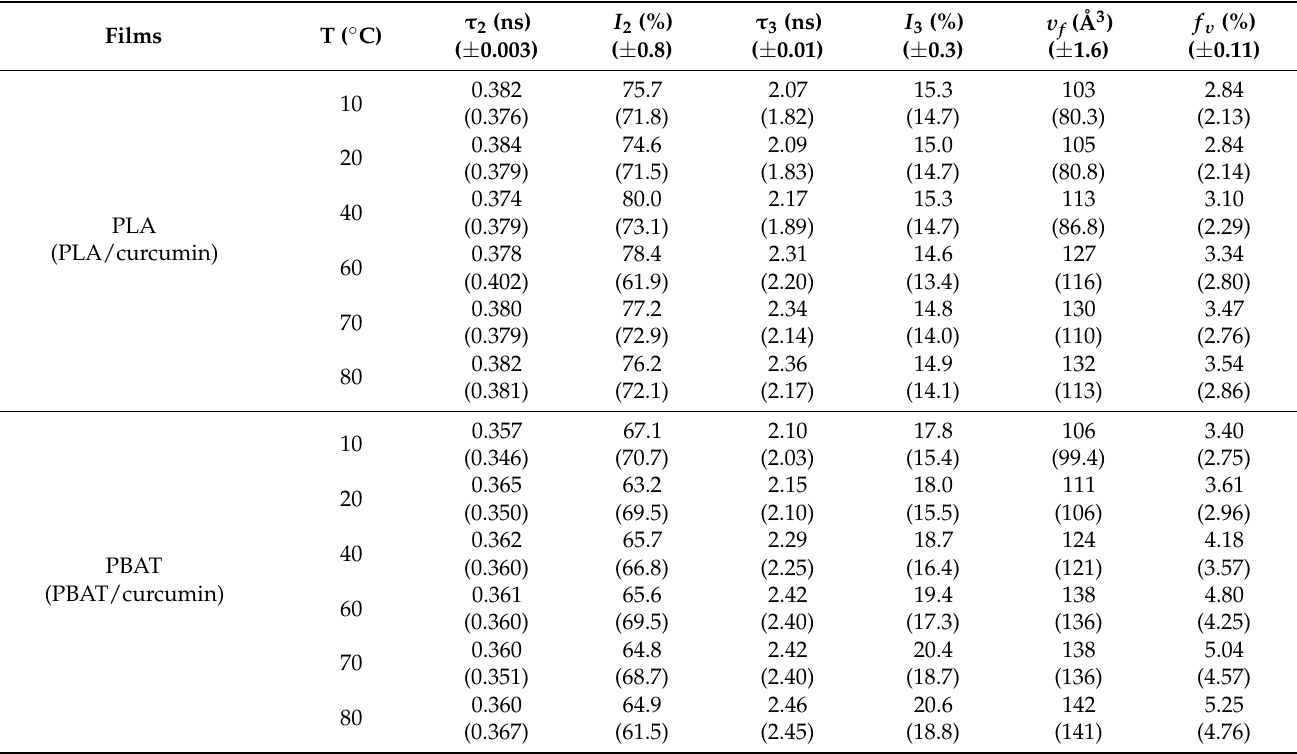
Table 2. PALS parameters as lifetimes ( τ 2 and τ 3 ) and intensities ( I 2 and I 3 ) with free volume hole size ( υ f ) and free volume fraction ( f υ ) in terms of temperature for PLA, PLA/curcumin, PBAT, and